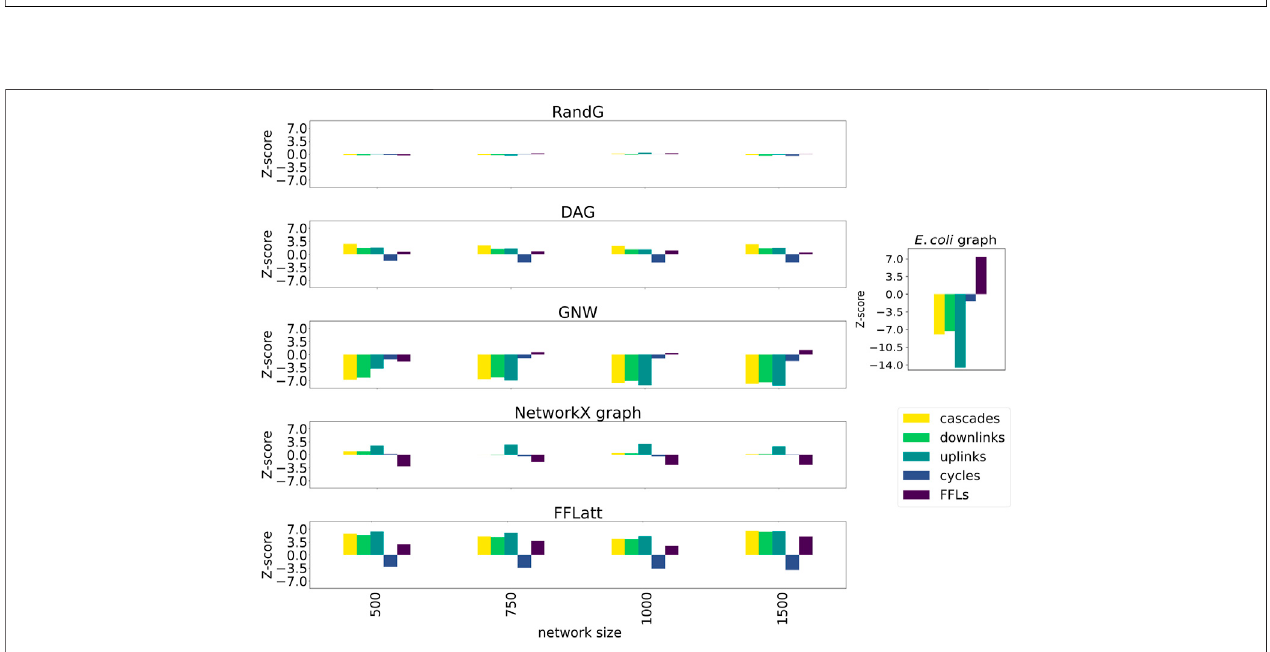
FIGURE6| Motif enrichmentanalysis of3-node network motifs insimulatednetworks( E.coli ).Fornetworks generated with GNW, the E.coli RegulonDB (Santos- Zavaleta et al., 2019) database was used. For networks generated with FFLatt, we used the graph properties for E. coli speci fi ed in Table 1 . RandG is a random assignment of links and DAG is the same with cycles removed. NetworkX graph GRNs are scale-free. For RandG, DAG, and NetworkX graph GRNs we used the E. coli network sparsity.